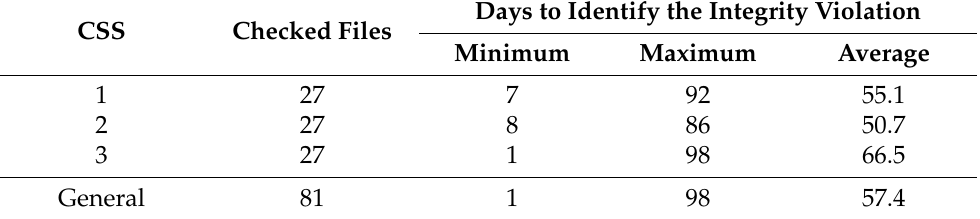
Table 8. Summary of the results of this